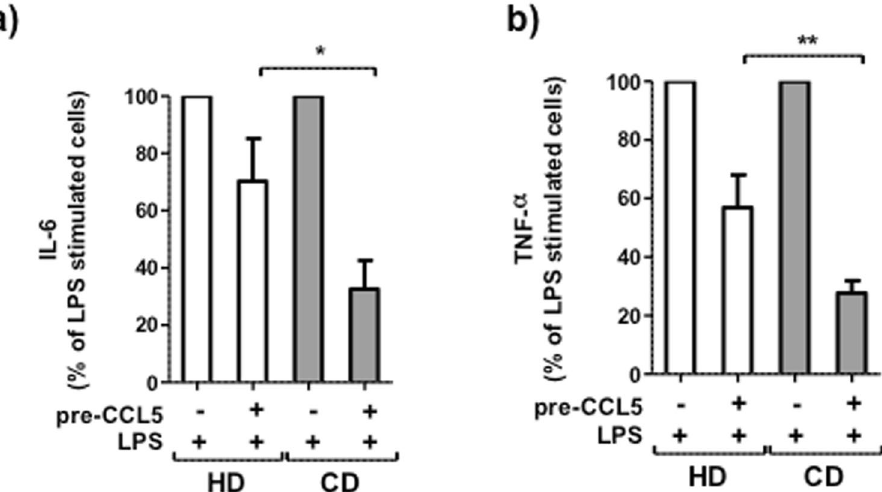
Figure 5. CCL5 suppressed LPS-induced IL-6 and TNF- α production by peripheral blood monocytes from HD and CD patients in remission. ( a , b ) Peripheral blood monocytes from HD (n = 6) and CD patients (n = 7) were cultured in medium alone for 24 h; then, cells were washed and stimulated with or without CCL5 (pre-CCL5) for 24 h. Subsequently, cells were washed and stimulated with or without LPS. The levels of IL-6 and TNF- α in the supernatants were quantified by ELISA. Mann-Whitney U test was used for the comparisons between HD and CD patients ( * p < 0.05, ** p < 0.01).